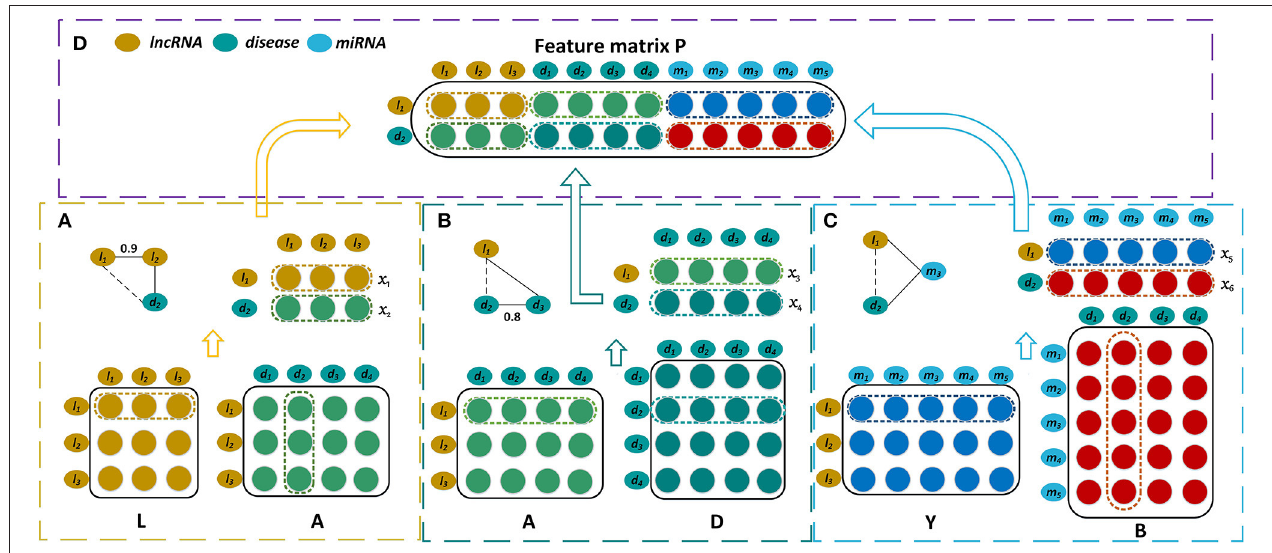
FIGURE 1 | Construction of the feature matrix of lncRNA l 1 and disease d 2 . (A) Construct the first part of feature matrix by integrating the lncRNA similarities and the lncRNA-disease associations. (B) Construct the second part by incorporating the lncRNA-disease associations and the disease similarities. (C) Construct the third part by exploiting the lncRNA-miRNA interactions and the miRNA-disease associations. (D) Concatenate these three parts to form the feature matrix P .